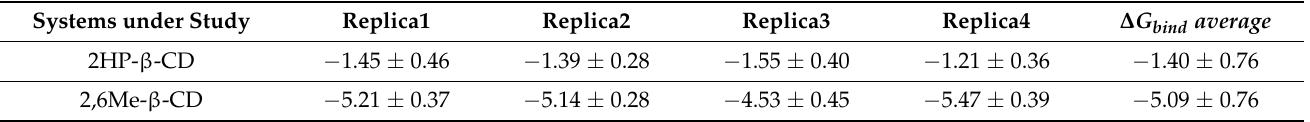
Table 10. Absolute free energies of binding (kcal/mol) for the QUE/2HP- β -CD and QUE/2,6Me- β - CD complexes calculated by non-equilibrium TI simulations for four different simulation replicas. Systems under Study